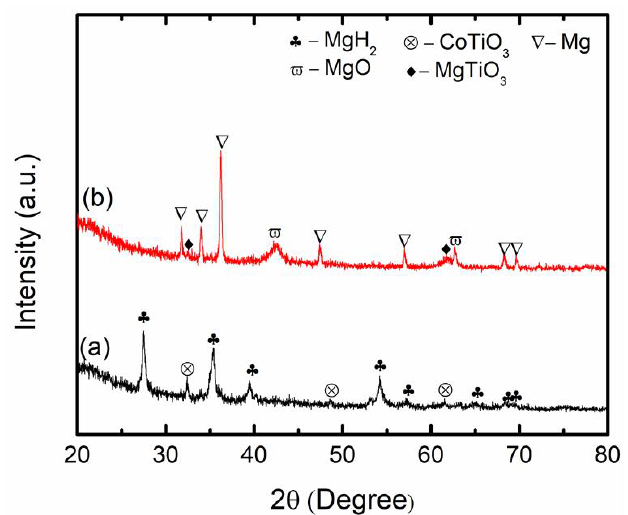
Figure 8. XRD patterns of ( a ) as-milled and ( b ) after desorption at 450 °C of MgH 2 + 10 wt.% CoTiO 3 .